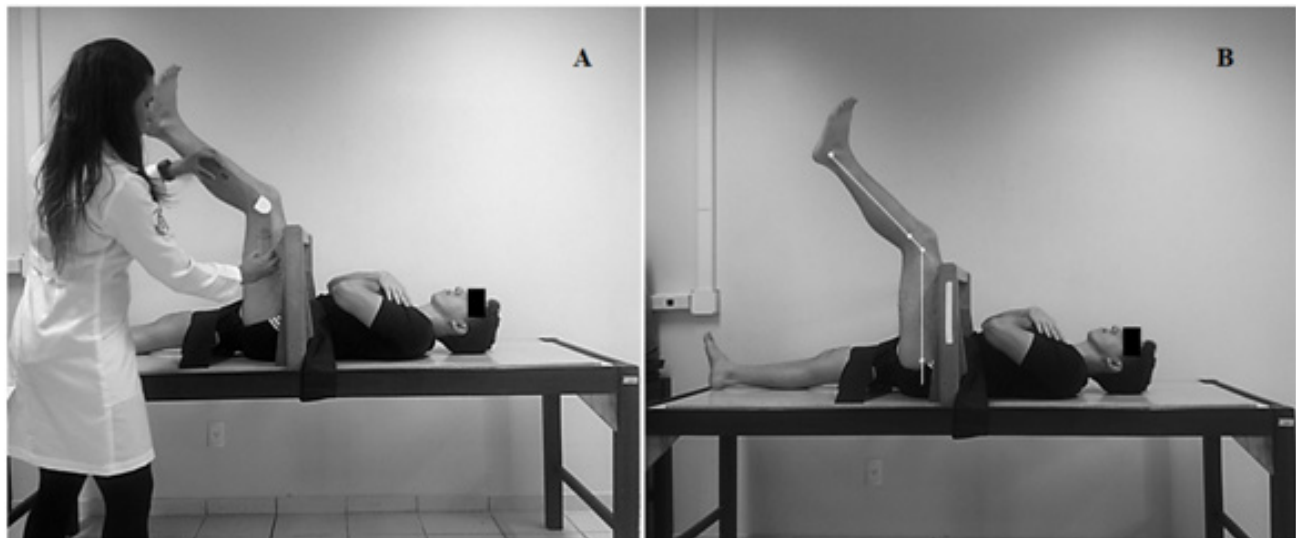
Figure 2. (A)“Blind” measurement of range of movement (ROM) through manual goniometry. (B) Angle of active knee extension ROM analyzed through computerized